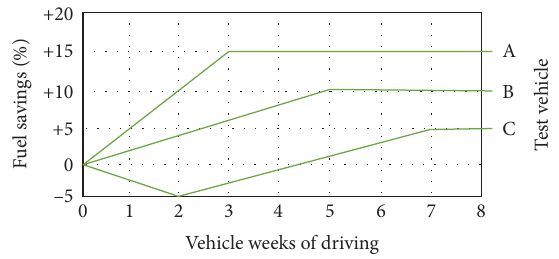
Figure 4: Fuel additive cumulative effect